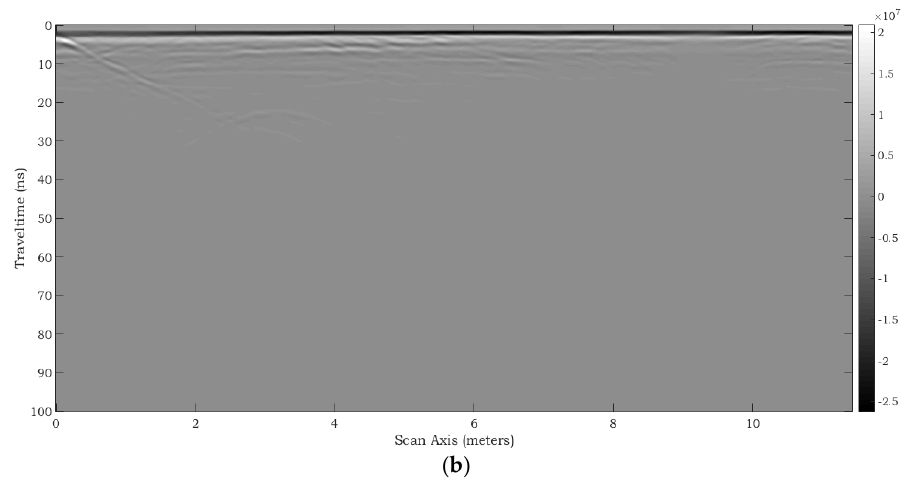
Figure 36. Profiles recorded in the Gneiss 0/20 gravel region by using GPR 1, on acquisition line 1, with last-generation antennas operating at: ( a ) 270 MHz; ( b ) 350 MHz.